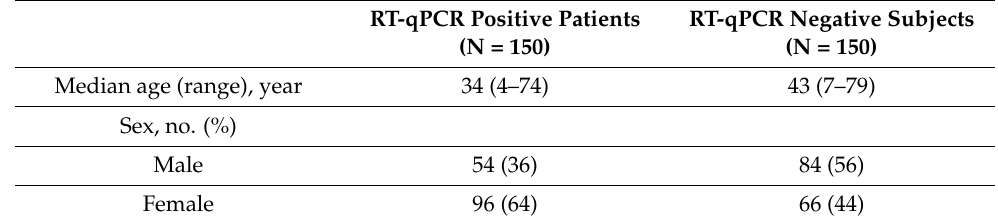
Table 1. Demographic and clinical characteristics of subjects.